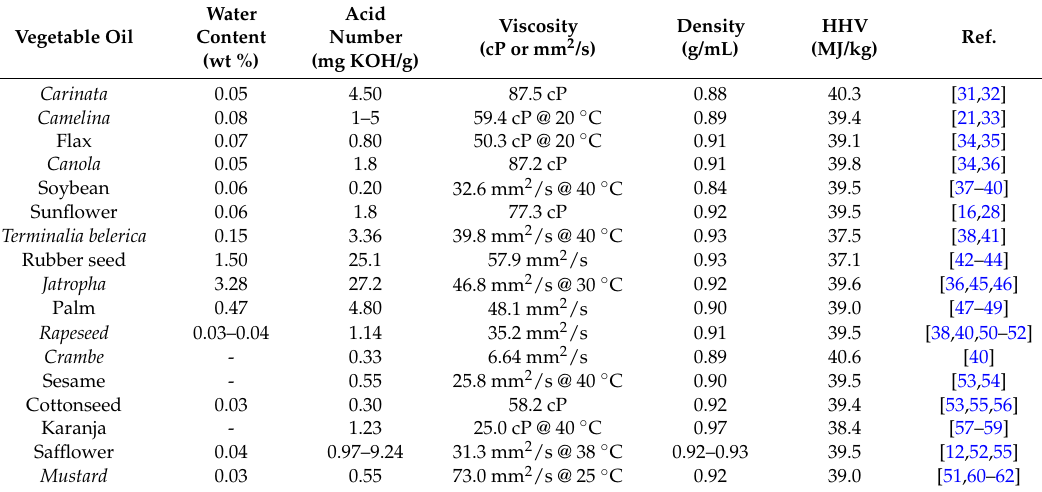
Table 1. Typical properties of vegetable